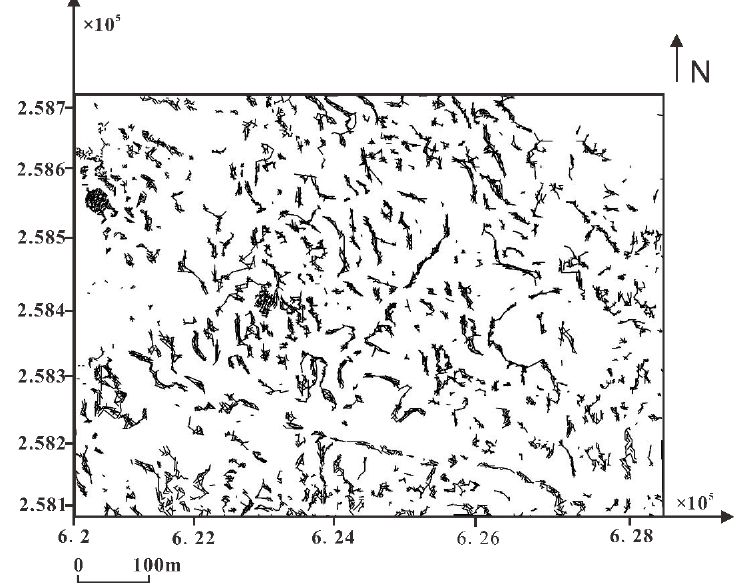
Figure 13. Lineaments by computer automatic connection.